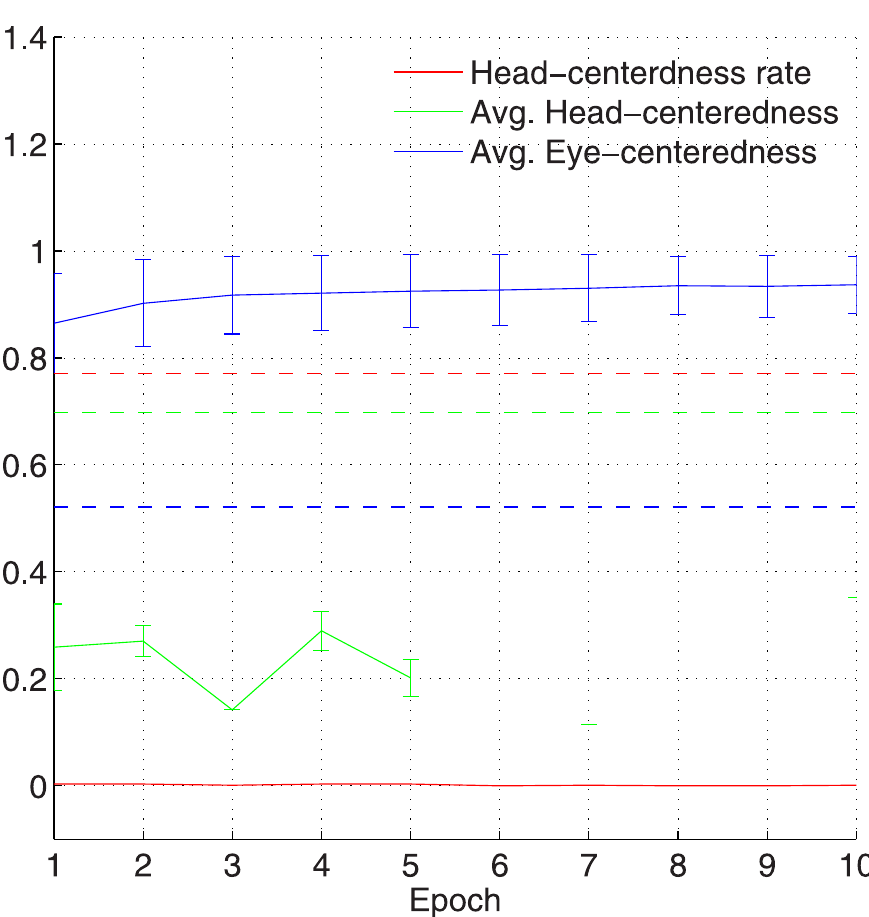
Fig 10. The effects of introducing synaptic plasticity into the network that has been manually prewired to produce head-centred output neurons when the input neurons that are modulated by a sigmoidal (monotonic) function of eye-position. The figure shows population analyses of the response properties of output neurons in the manually prewired model as the synaptic weights are further modified during ten training epochs with the standard trace learning rule (6). Three key summary statistics are given. The head-centredness rate (red) is the fraction of head- centred neurons in the output population. The average head-centredness (green) is the average head-centredness among head-centred neurons, and becomes undefined if no head-centred neurons are found to exist. The average eye- centredness (blue) is the average eye-centredness among all output neurons. The dashed lines show these values for the manually prewired network before training, while the unbroken lines show the values through successive training epochs after synaptic plasticity has been introduced. The error bars are the standard deviations. It can be seen that by the end of the first training epoch the majority of the output neurons switched from being head-centred to eye- centred.